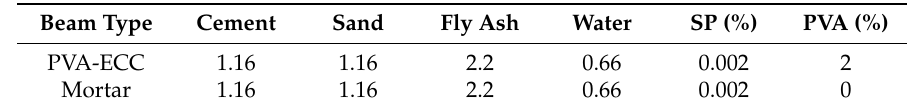
Table 2. Compositions of polyvinyl alcohol fiber reinforced engineering cementitious composite (PVA-ECC) and mortar.